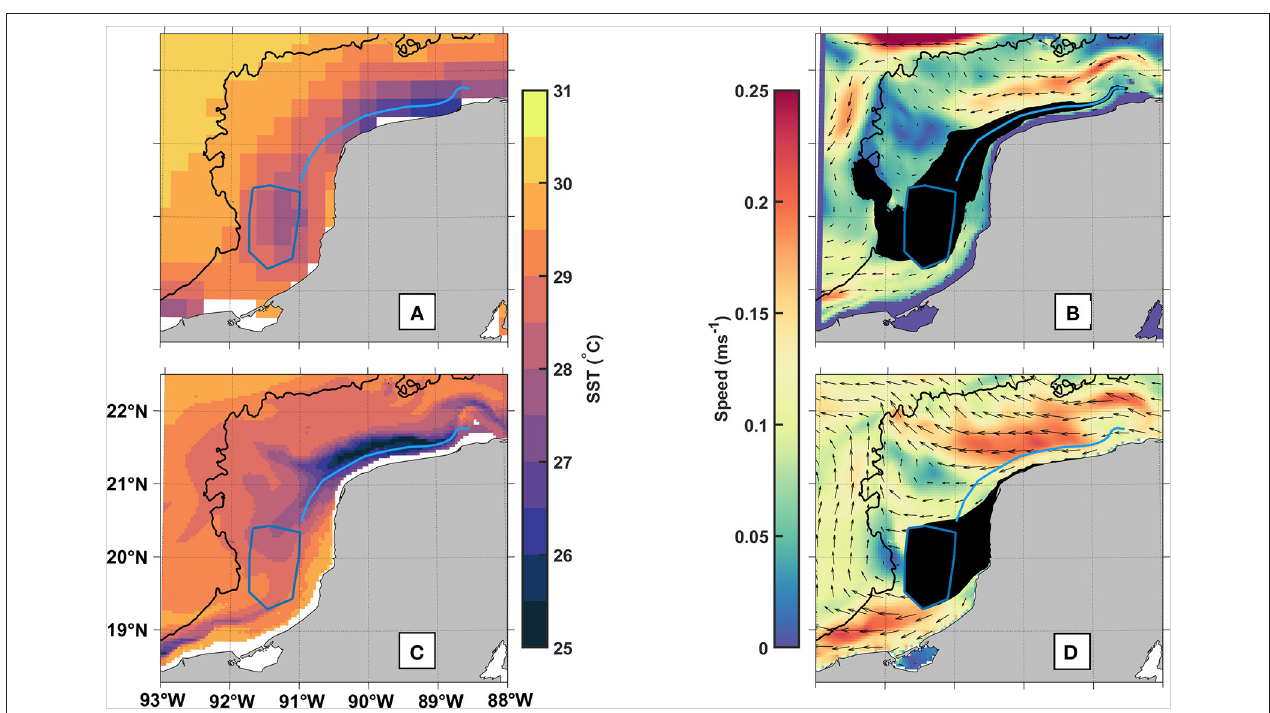
FIGURE 10 | Sea surface temperature ( ◦ C) from satellite (A) and HyCOM GoM (C) on July 19, 2018. The blue polygon is used as initial conditions for back-in-time trajectories to investigate the cool water pool origin in the satellite data (A) . Black dots in the right column are points from trajectories initiated within the blue polygon (July 19, 2018) and integrated back-in-time for 40 days (June 10, 2018) using HyCOM GoM velocity at 5m depth (B) , and a 1994–2014 climatological velocity at the surface (D) . Color contours in the right column are the velocity magnitude (ms − 1 ) used for the trajectories after time averaging, HyCOM GoM at 5m depth is shown in (B) , and the velocity climatology at the surface is shown in (D). The blue line is used as a path representative of most of the trajectories shown in (B) and is plotted as a reference in the other panels. The 50-m isobath is shown in black ( Figure 10